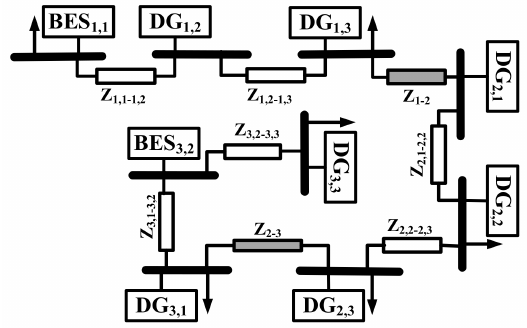
Figure 3. Schematic diagram of the simulated DC multi-MGs. Table 2. Parameters of The Tested DC